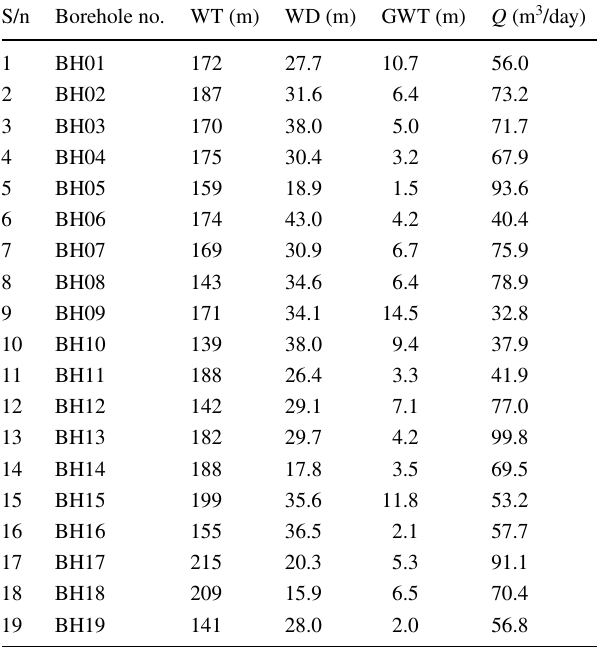
Table 3 Results of groundwater discharge and well inventory data S/n Borehole